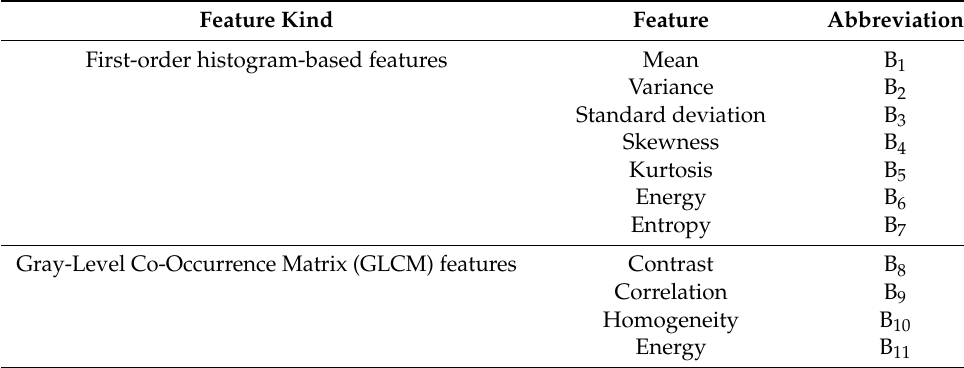
Figure 2. Sample thermal image with possible expected defects.